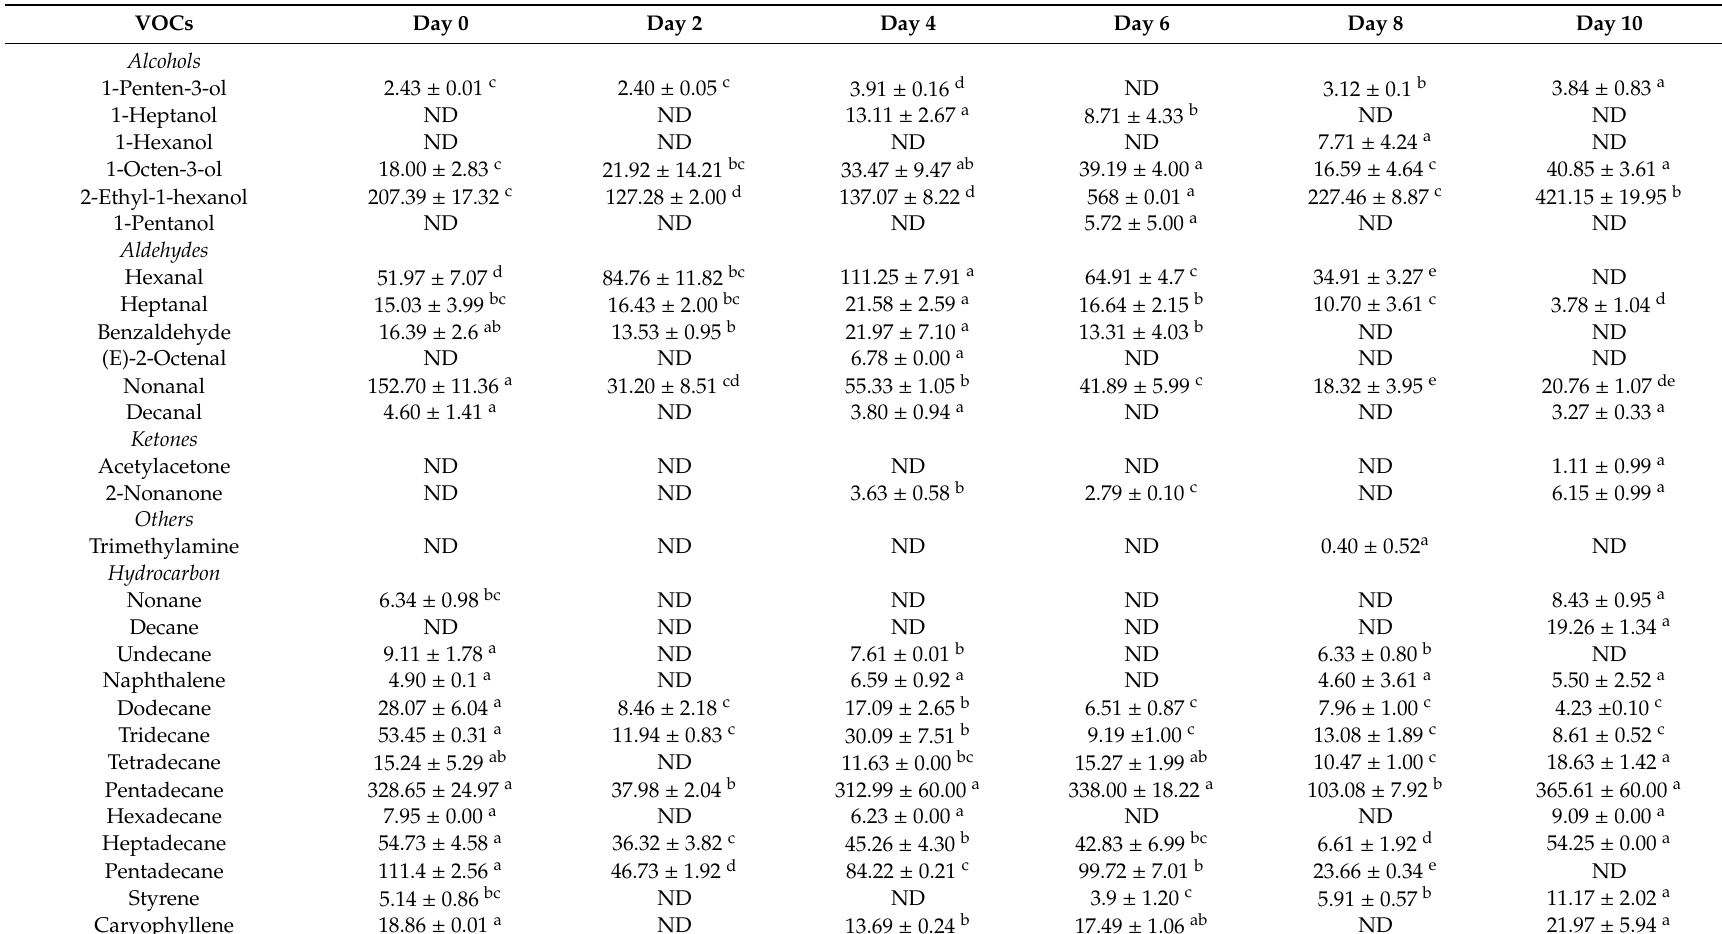
Table 4. Volatile compounds of hybrid grouper by HS-SPME-GC-MS at 4 ◦